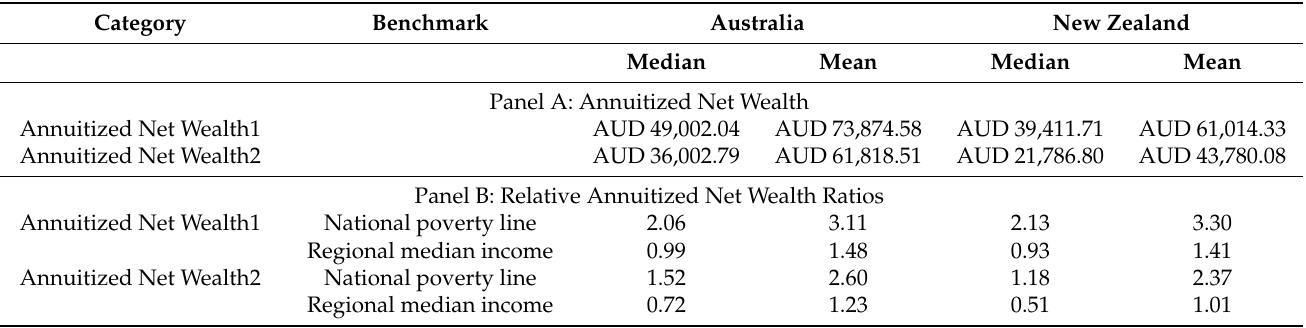
Table 3. Absolute and relative annuitized net wealth comparisons.